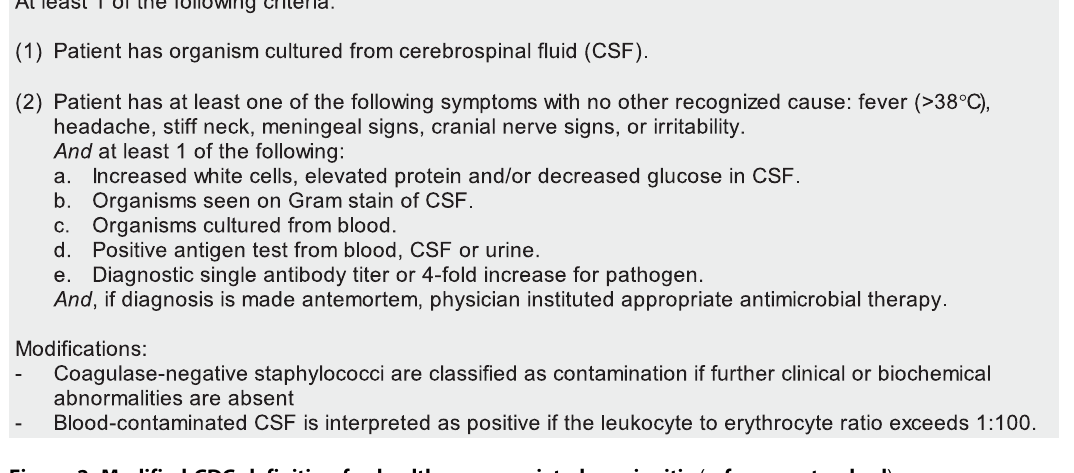
Figure 2. Modified CDC-definition for healthcare-associated meningitis ( reference standard ) .